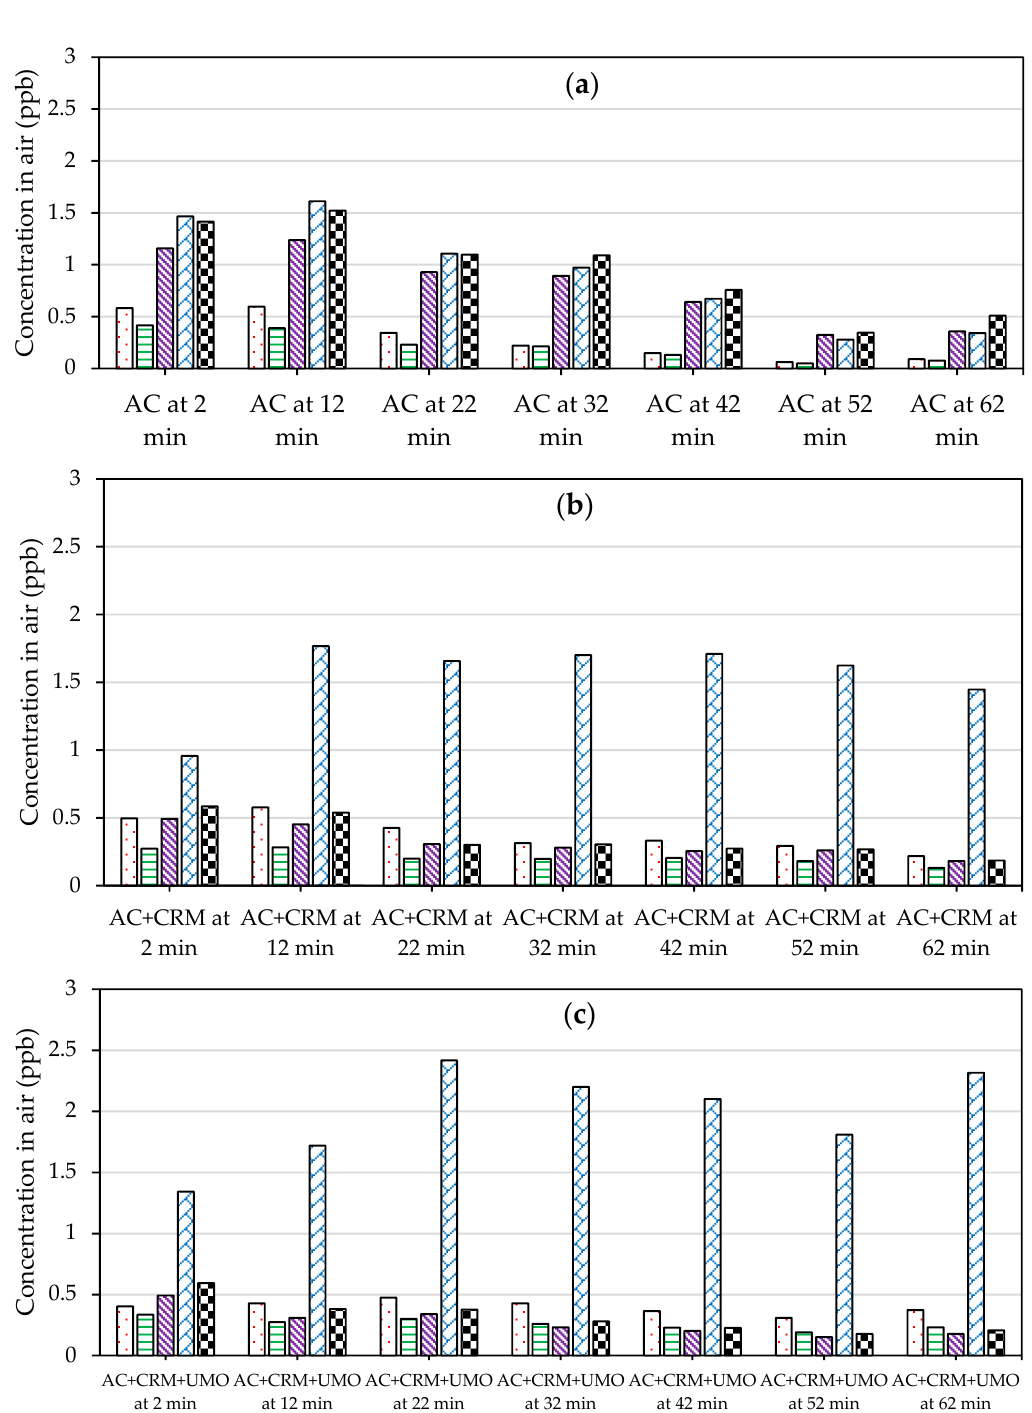
Figure 19. BTEX in air above PG 64-22 neat and modified asphalt binder samples interacted at 190 °C—50 Hz and different interaction times; these samples were ( a ) neat asphalt binder (AC); ( b ) AC + 10% CRM; ( c ) AC + 10% CRM + 2.5% UMO.